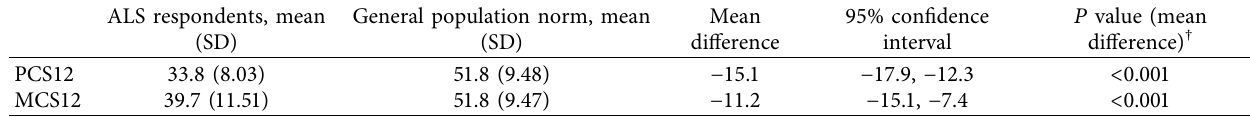
Table 3: RAND-12 component scores compared to the general population